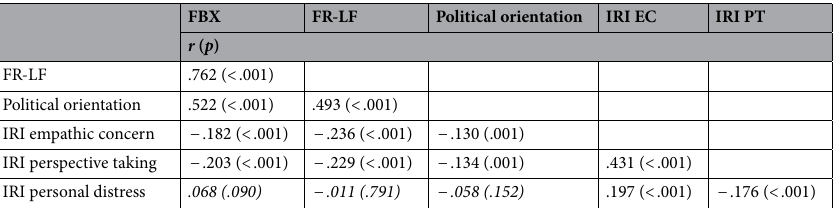
Table 3. Correlations between measures of trait empathy, xenophobia, and political ideology. FBX fear-based xenophobia, FR-LF right wing extremist attitudes, IRI interpersonal reactivity index; political orientation (1 = left, 7 = right).